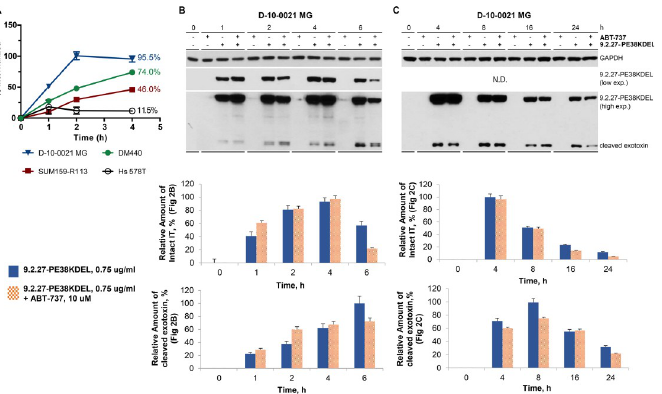
Fig 2. Time course analysis of internalization of 9.2.27-PE38KDEL on selected xenografts and cell lines, by flow cytometry and western blot. A. The percentage of IT internalized into the cells at 4 h by flow cytometry was labeled for each xenograft or cell line, in its corresponding color. B and C. GBM D-10-0021 MG cells were left untreated or treated with 9.2.27-PE38KDEL (0.75 μ M) only, ABT-737 (10 μ M) only, or the combination from 1 h to 24 h. Cell lysates were subjected to western blot analysis with GAPDH or Pseudomonas exotoxin antibodies. Lower panels represent the relative intracellular accumulation of intact 9.2.27-PE38KDEL and furin processed cleaved exotoxin (PE38KDEL). The values represent the average of 3 experiments, and the error bars represent SEM.